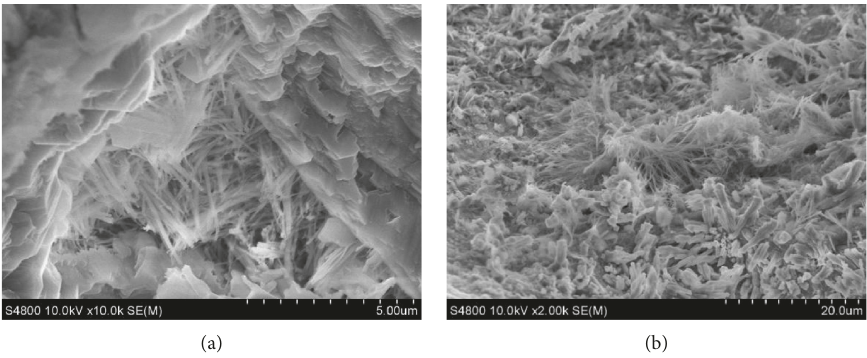
Figure 21: SEM of the mortar (SJ12). Note: AFt is acicular; gypsum is